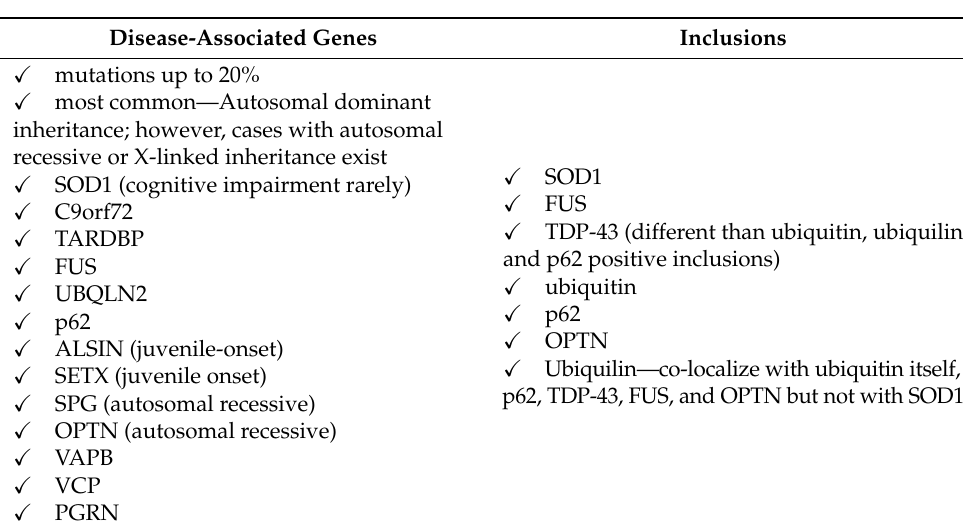
Table 2. Summary of characteristics genes and inclusions in FALS cases.